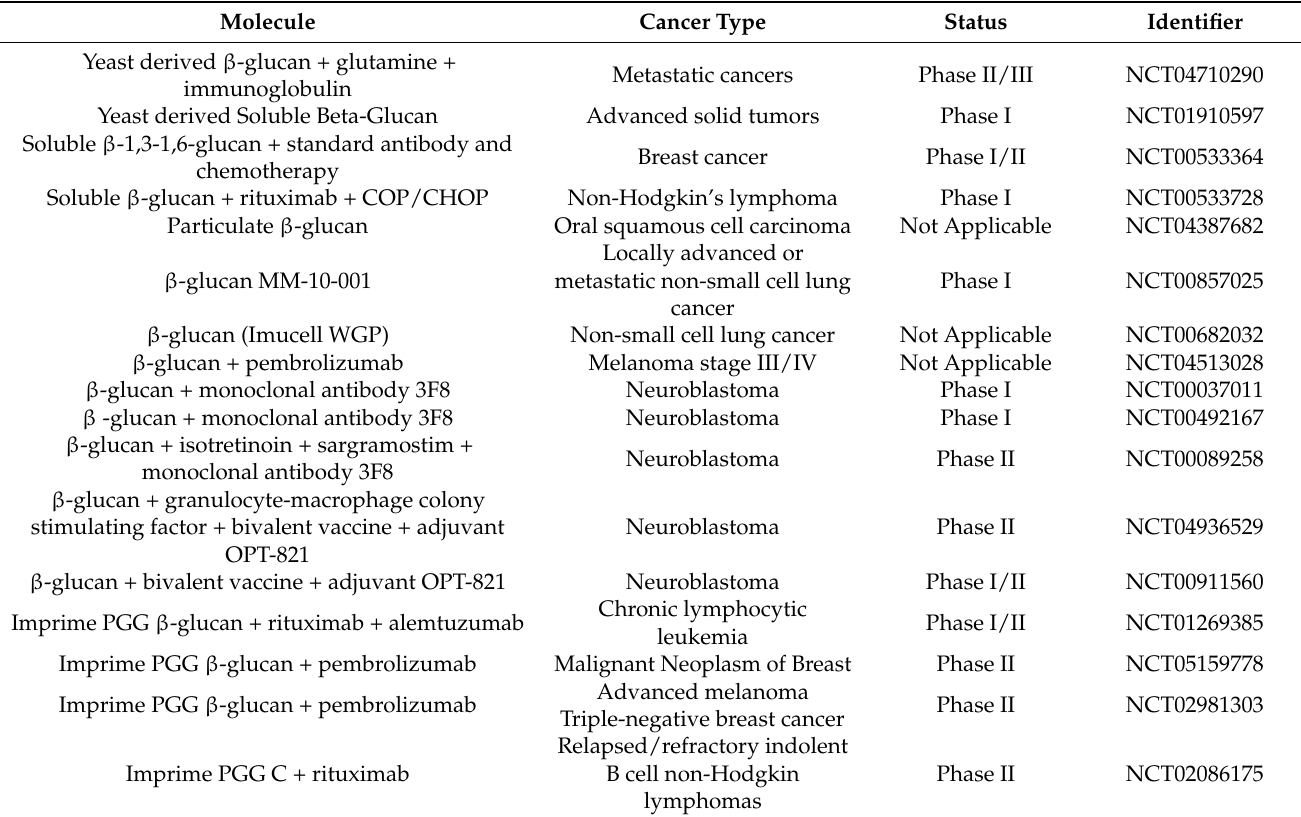
Table 2. Ongoing and completed clinical trials involving β -glucans for cancer treatment, according to the clinicaltrials.gov database (as of 25 February 2022)